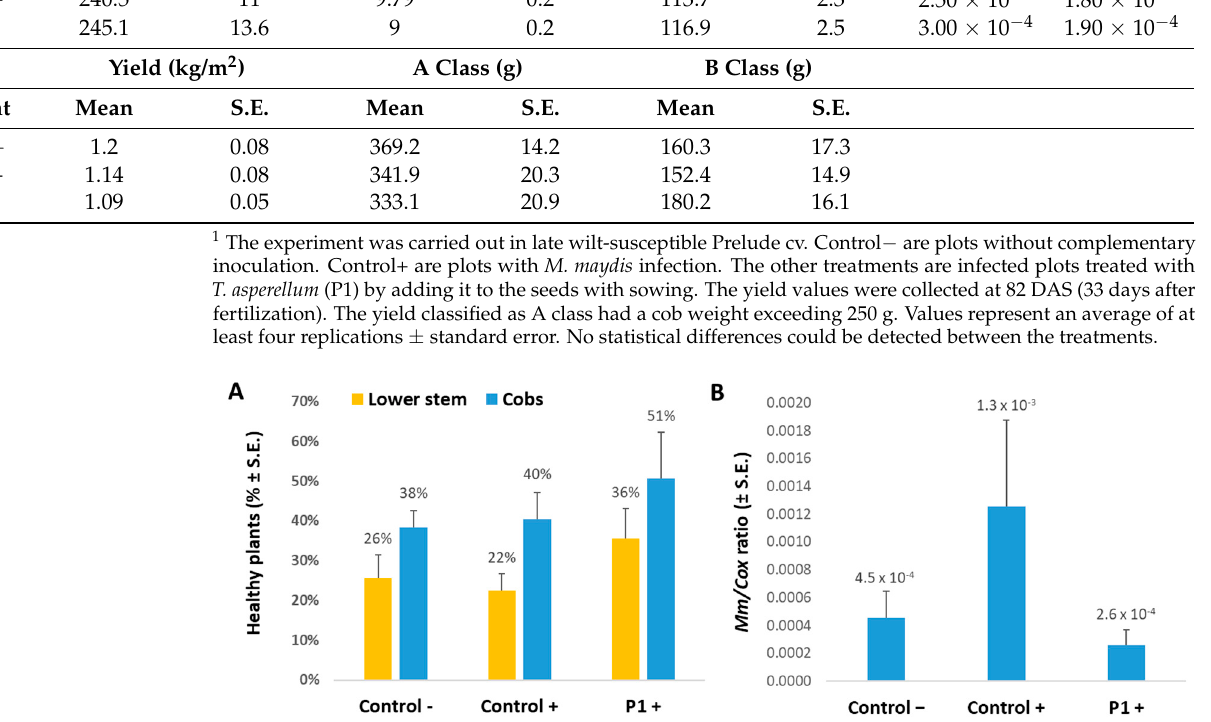
Figure 2. Plants’ health and M. maydis infection severity in the field at day 82. Maize late-wilt disease symptoms ( A ) and qPCR diagnosis of M. maydis DNA in maize plants ( B ) at the end of the field experiment (33 days after fertilization) conducted in the summer and autumn of 2020. The experiment was conducted with the late-wilt-susceptible maize genotype Prelude. Control − are plots without complementary inoculation. Control+ are plots with M. maydis infection. The other treatments are infected plots treated with T. asperellum (P1) by adding it to the seeds with sowing. M. maydis relative DNA ( Mm ) normalized to the cytochrome C oxidase (Cox) DNA was evaluated in the plants’ first aboveground internode. Vertical upper bars signify the standard error of the mean of 4-10 replicates.